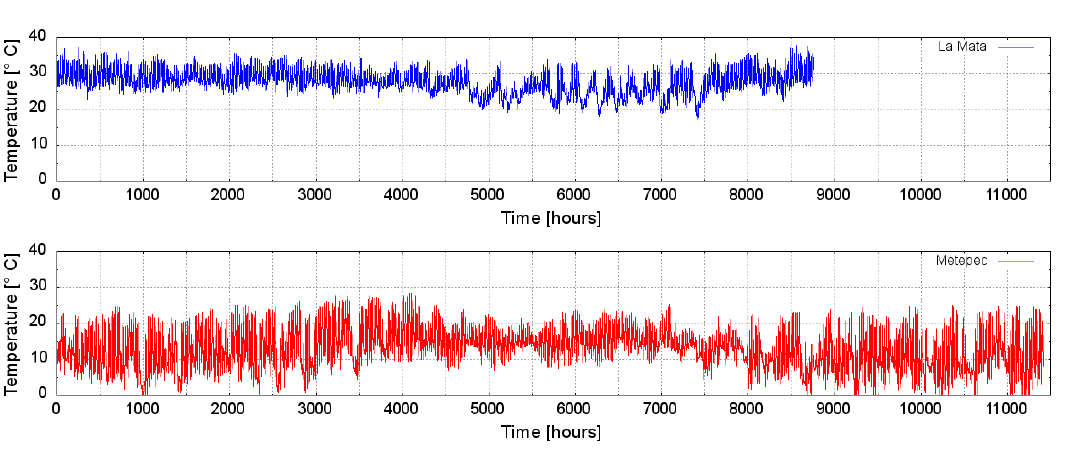
Figure 3. Air temperature time series from La Mata, Oaxaca (hourly averages) and Metepec, Hidalgo (ten-minute averages).